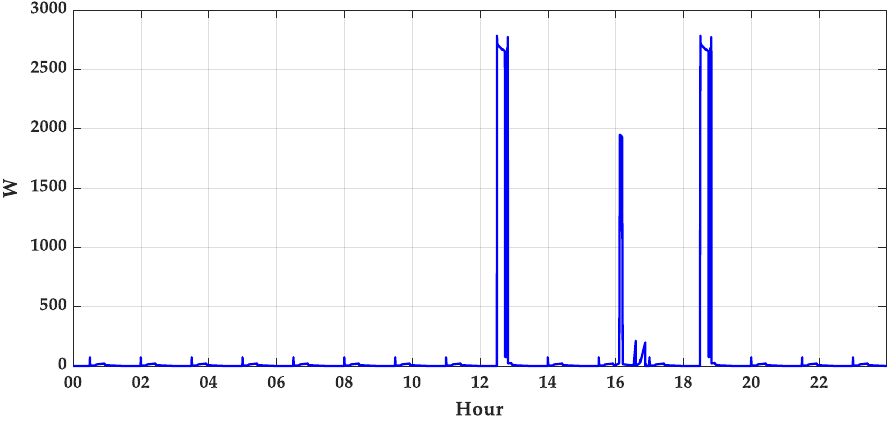
Figure 24. Artificial daily-load profile.